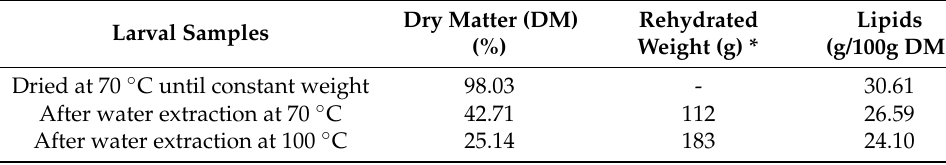
Table 1. Lipids contained in the larval samples.